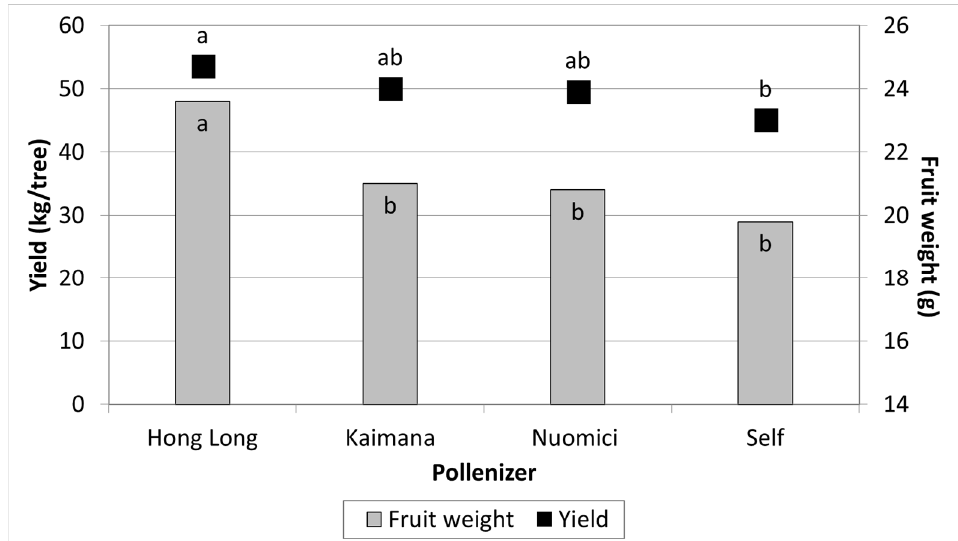
Figure 2. The effect on fruit weight and yield of MA adjacent to different pollinizers, Lavi 2017. Mean values of each column followed by different letters differ significantly per Duncan’s new multiple range test, p < 0.05. Data on yield are the means of 6 MA trees (6 replicates) adjacent to each pollinizer. Data of fruit weight are the mean of 100 randomly fruit from each of the 6 trees per treatment. Table 3. The effect of the pollinizer HL on the yield and fruit weight of MA trees in the greenhouse, Orchard Farm